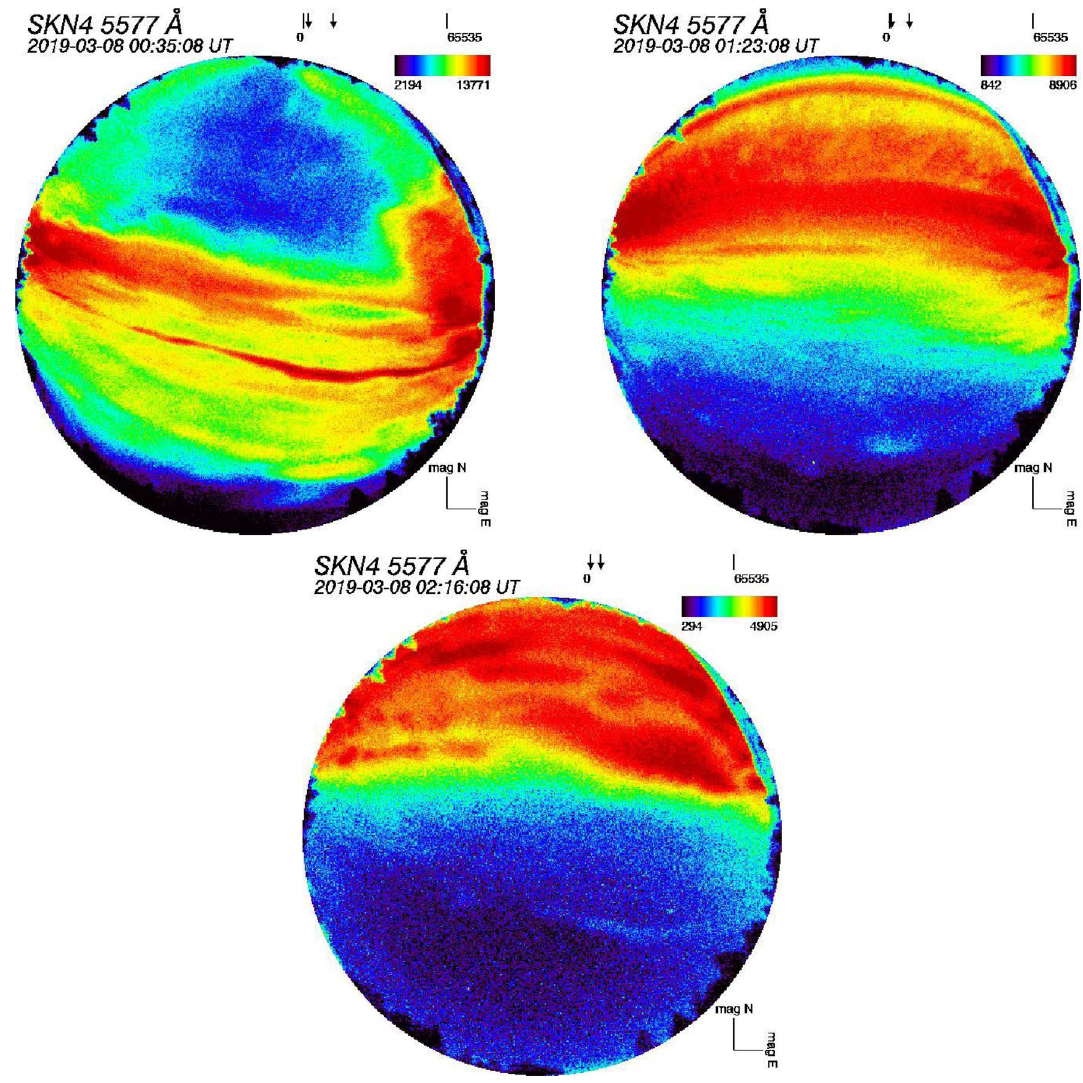
Fig. A.3. All-sky camera images of the auroral emissions in the 557.7 nm line used as input of the model for the purple (top left), green (top right), and blue (bottom) observations on March 8th, 2019. The color scale gives the emission photon fl ux in Rayleigh units (10 10 photons/m 2 /s/